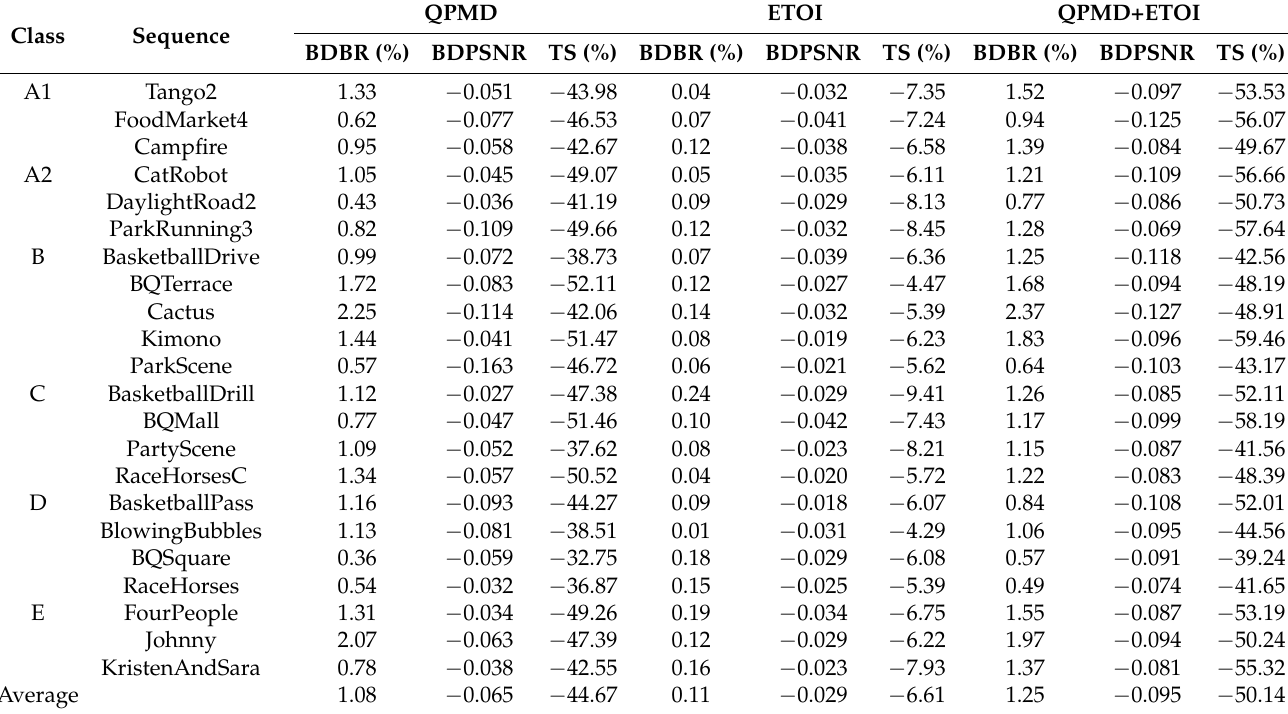
Table 1. Performance of the QPMD and ETOI